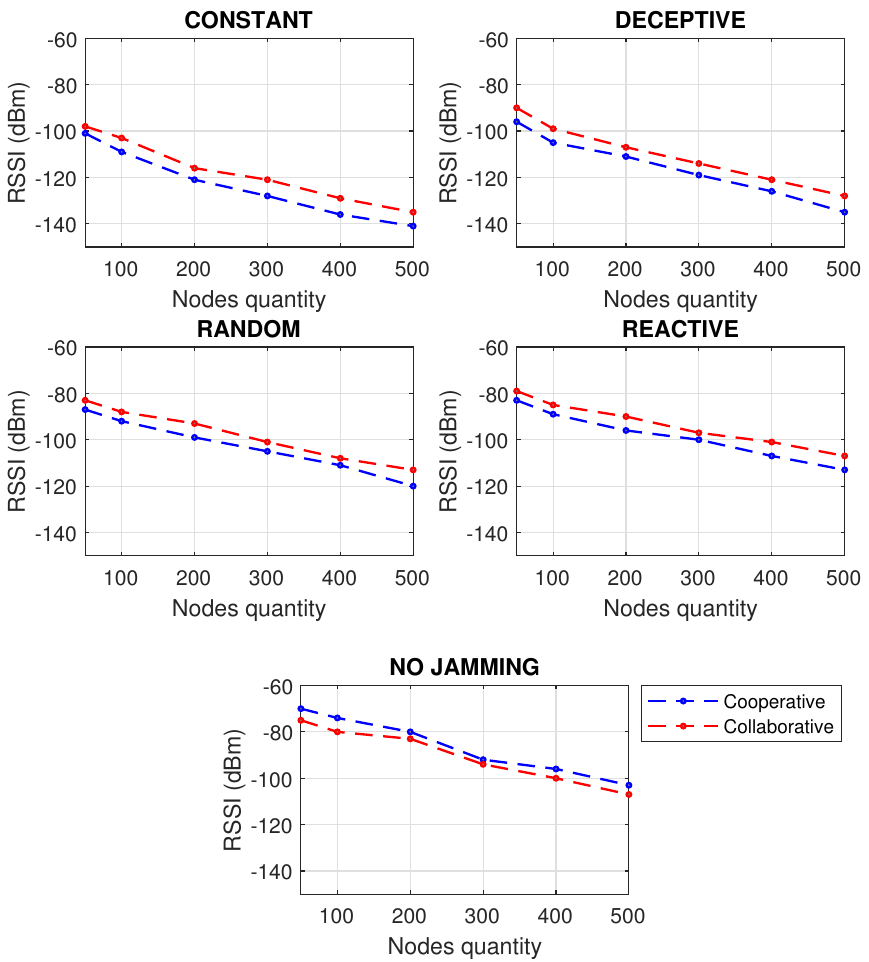
Figure 9. RSSI for types of jamming in a WSN of 500 m 2 with different number of nodes under collaborative and cooperative